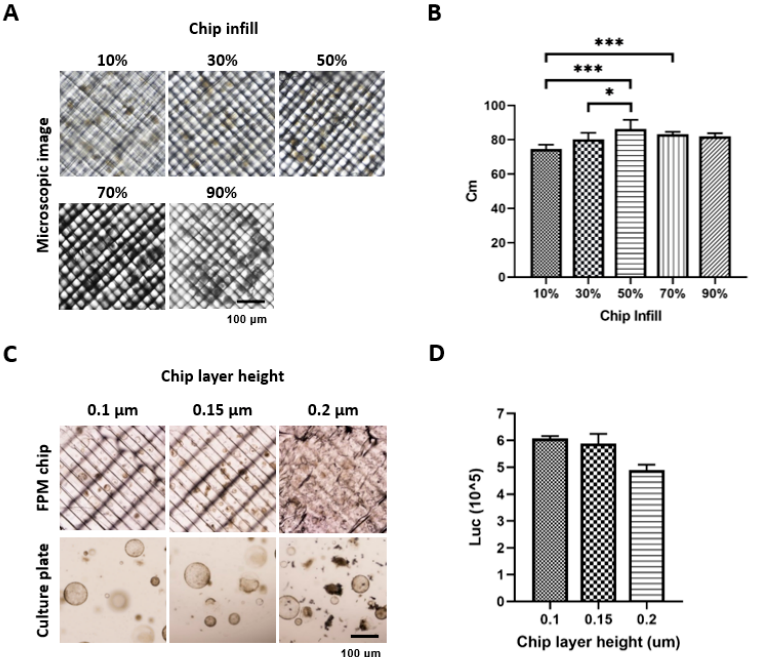
Figure 1. Optimization of the chip infill to visualize the organoid or spheroid under microscopy. Different conditions of the infill (10%, 30%, 50%, 70%, and 90%) were applied to fabricate the chip. Six images of organoid and spheroid on the chip were taken for each condition, and image sharpness was evaluated by calculating the Cm index. An infill condition of 50% showed a significantly higher sharpness compared to any other condition ( p < 0.05) ( A , B ). Next, the organoid viability was measured using CellTiter-Glo ® 3D, and the result showed that the 0.1 µ m thickness had the highest viability compared to the 0.15 µ m and 0.2 µ m thickness ( C , D ). The differences were considered significant at p < 0.05 (*), p < 0.001